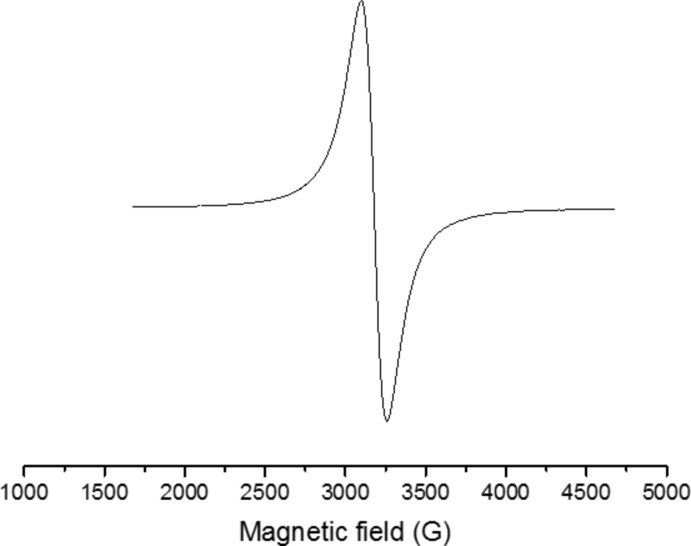
CW–EPR spectrum for the title complex measured at 100 K.